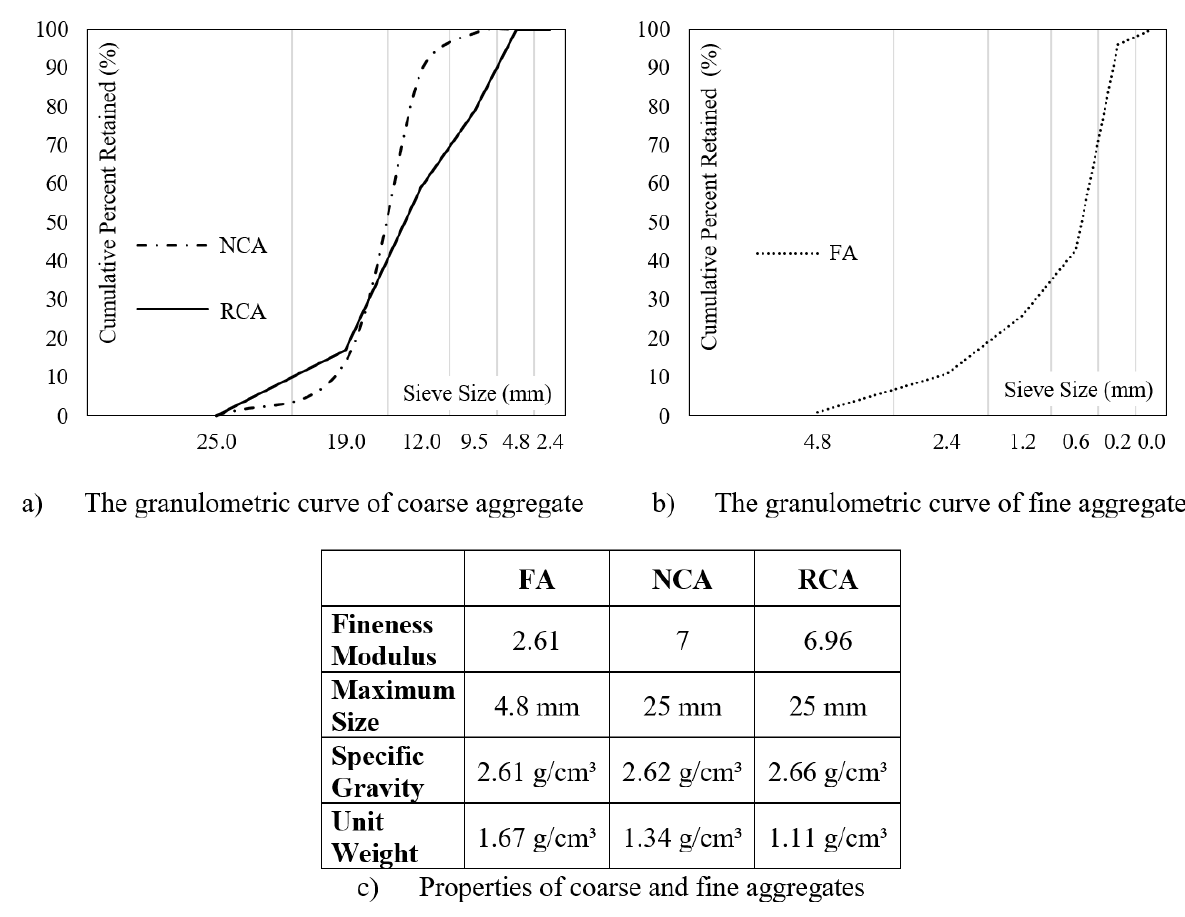
Figure 1. Aggregates